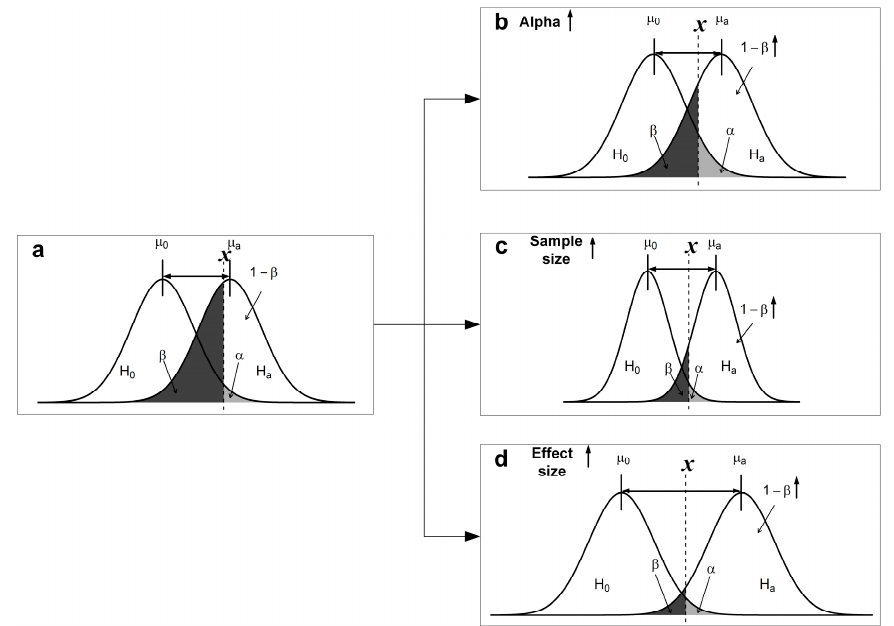
Figure 3. The effect of significant level ( α ), sample size, and true effect size on the statistical power. Statistical power for one sample test for the mean of a normal distribution with know variance ( a ). The statistical power increases in case: ( b ) α increases or β decreases; ( c ) sample size increases; ( d ) effect size increases